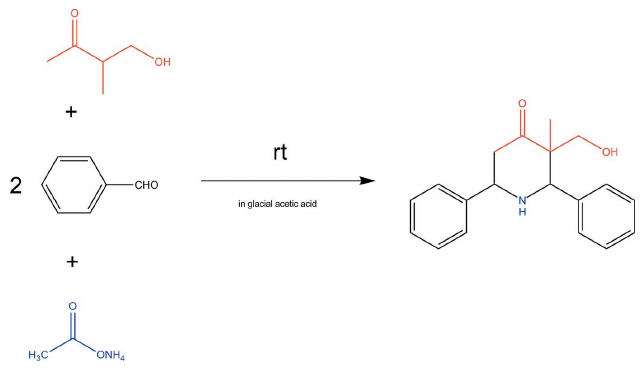
Figure 5 The synthesis of 3-(hydroxymethyl)-3-methyl-2,6-diphenylpiperidin-4- one.